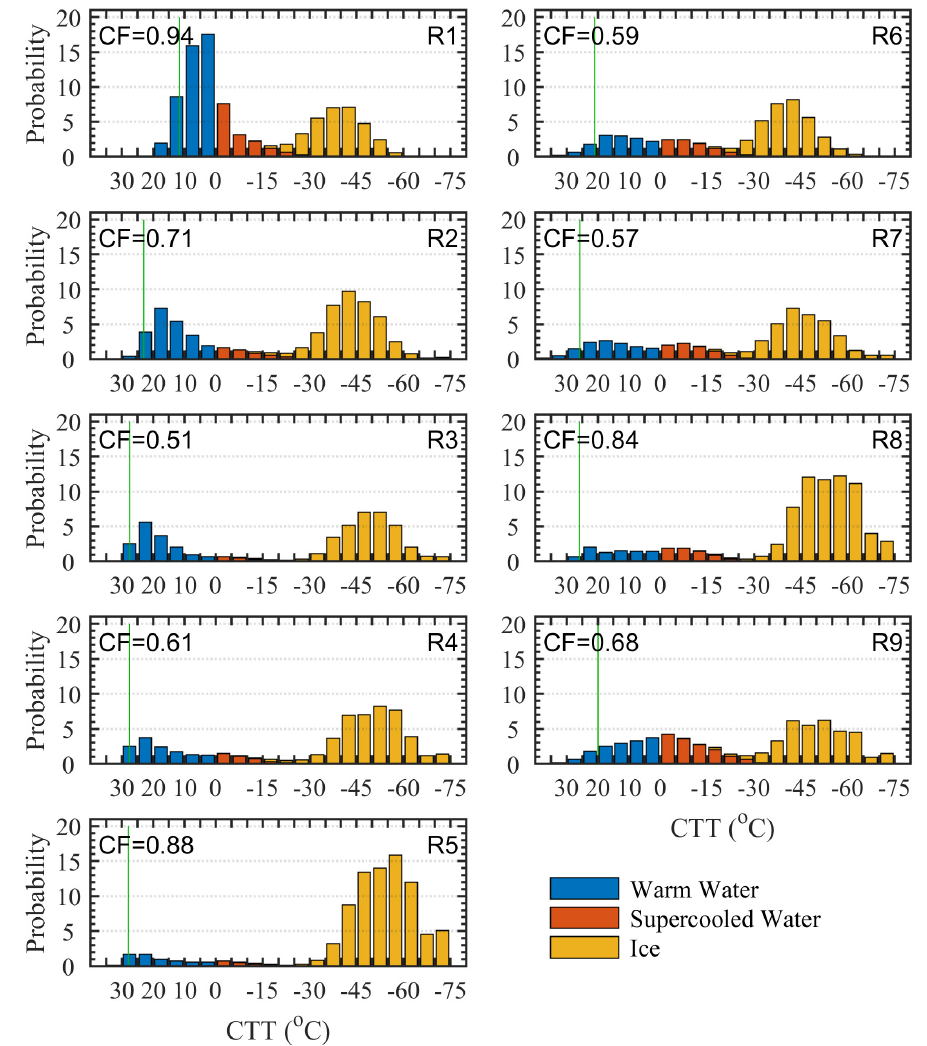
Figure 7. Probability (unit: %) distributions of cloud-top phases, divided into 5 °C intervals of cloud-top temperature (CTT), for the nine regions of interest in the 3-year boreal summer. The frequency of total cloud occurrence (CF), which is the sum of all CTT bins of the probability, is given in the upper-left corner of each panel. Green vertical lines indicate the seasonal mean near-surface air temperature.